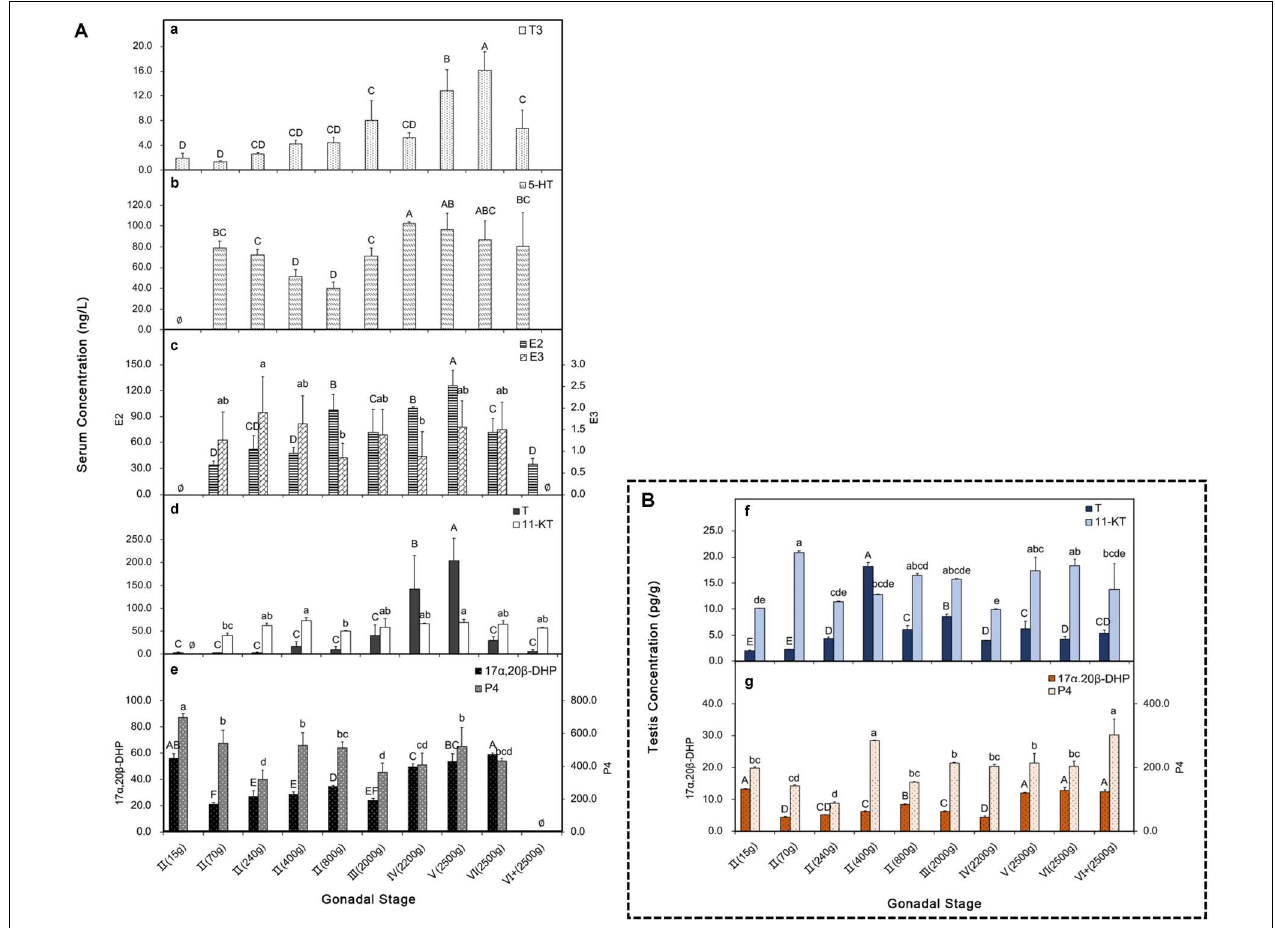
FIGURE 6 | Serum and testis hormones at different development stages. (A) (a–e) Serum hormones; (a) T3; (b) 5-HT; (c) E2 and E3; (d) T and 11-KT; (e) 17 α ,20 β -DHP and P4. (B) (f,g) Testis hormones; (f) T and 11-KT in testis; (g) 17 α ,20 β -DHP and P4 in testis. P < 0.05, n =